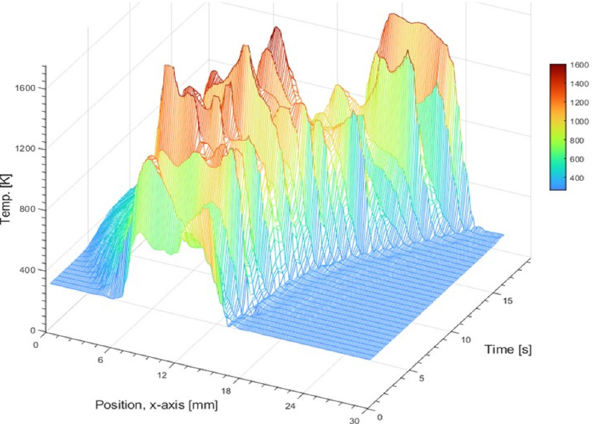
Figure 10. A theoretical simulation of the spatiotemporal evolution of the temperature profile during a scanning LMH–AM process (applied to a ~20 × 2 × 1 mm 3 powder layer, by a 200-W LMH applicator, at a ~1 mm/s scanning speed).